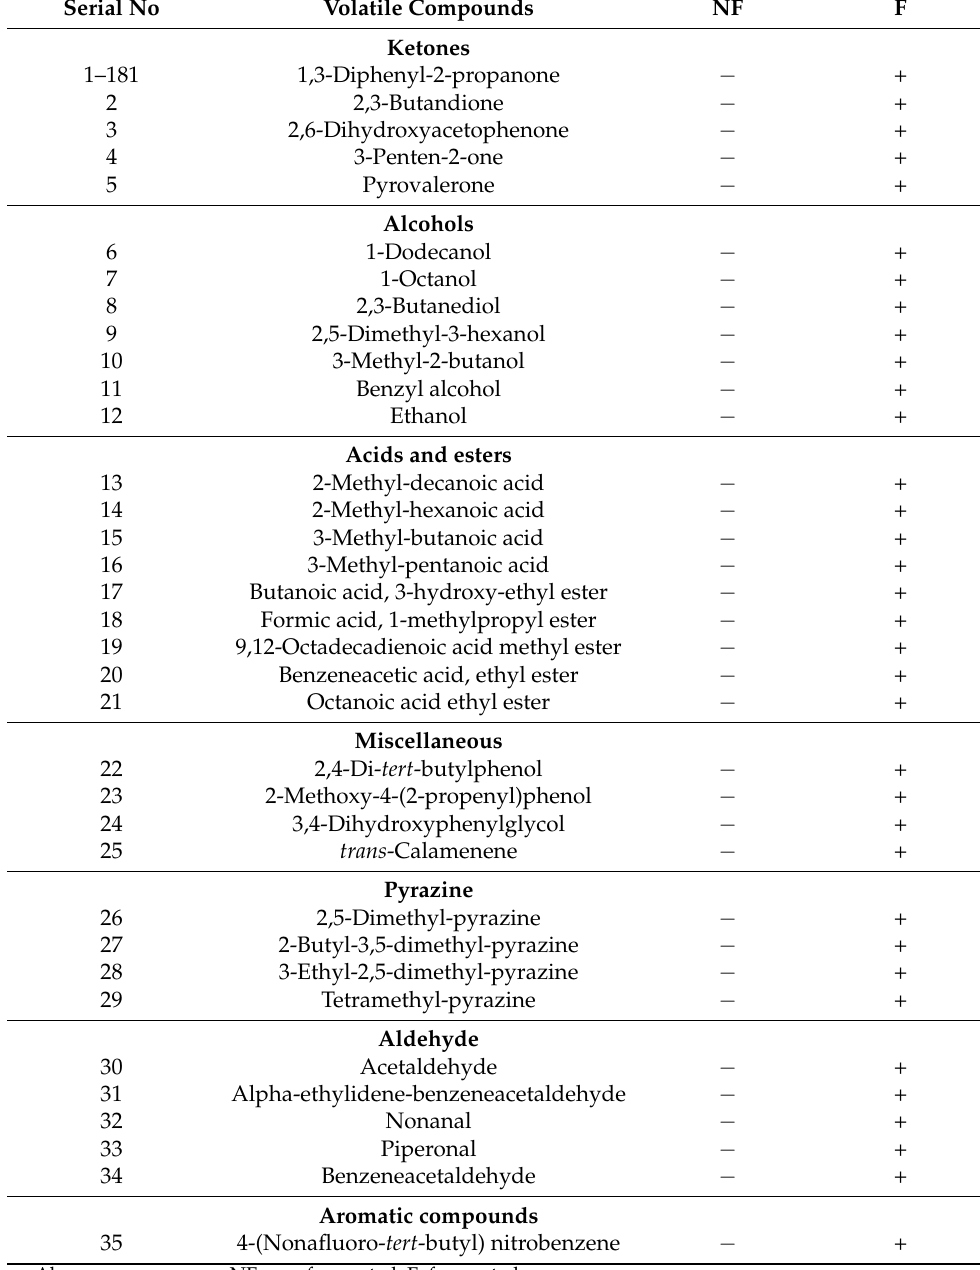
Table 1. Volatile compounds only present in CGJ fermented with pure B. subtilis